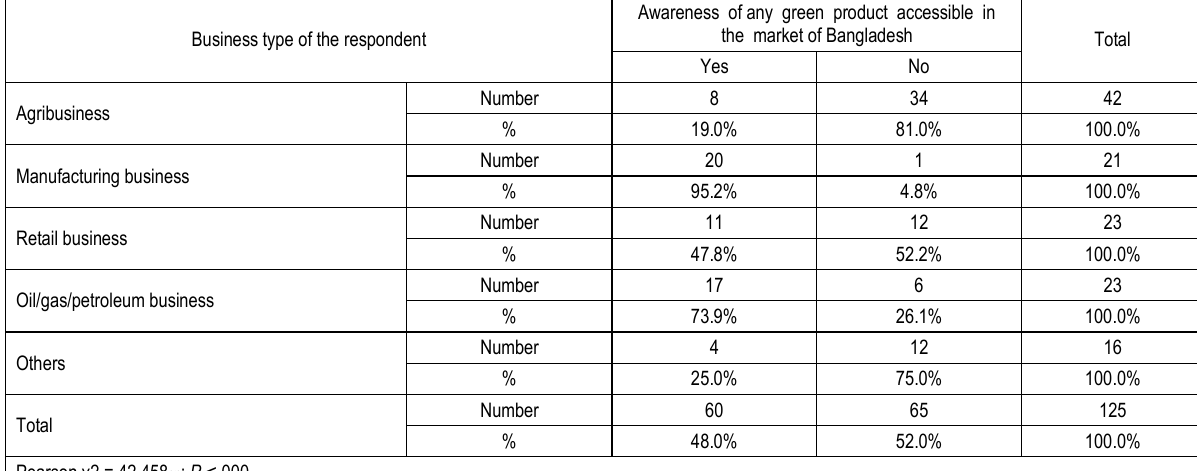
Table 3. Linkage between business type and awareness of any green product accessible in Bangladesh Business type of the